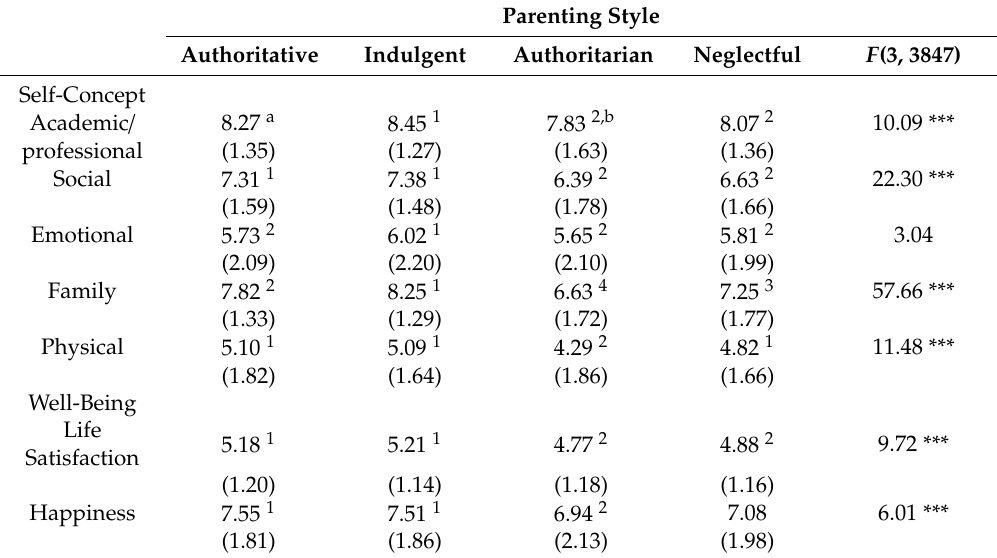
Table 4. Means and (standard deviations) of parenting style, generation, and sex, and main univariate F values for psychosocial adjustment (self-concept and well-being).